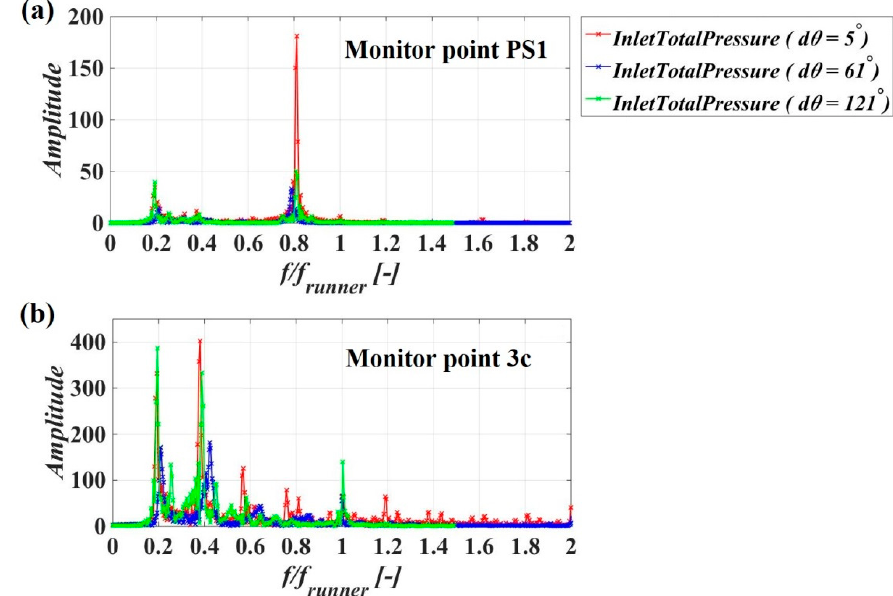
Figure 12. Amplitude spectra of the numerical pressure signal recorded throughout the load variation and PL operation. ( a ) Monitor point PS1 near the leading edge, on the pressure side of the blade. ( b ) Monitor point 3c on the draft tube cone wall.